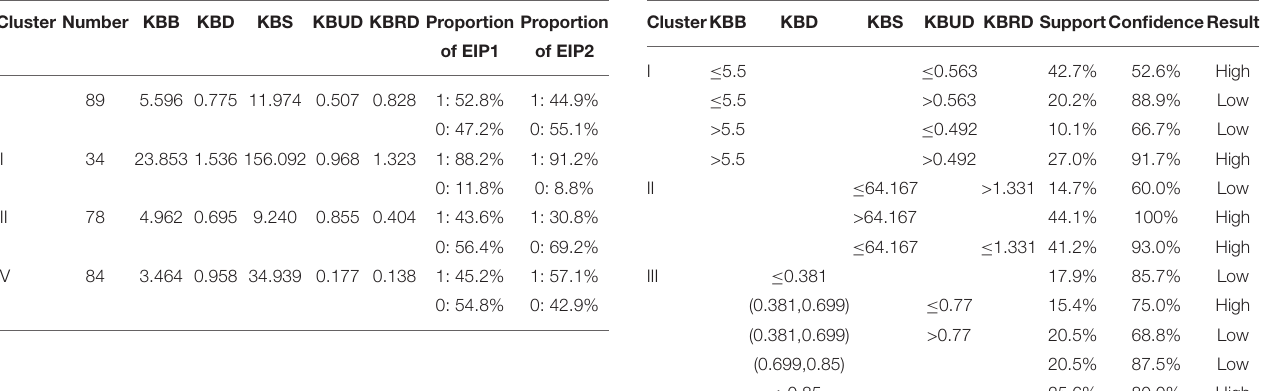
TABLE 1 | Statistical information in different clusters. TABLE 2 | Decision rules of exploratory innovation performance